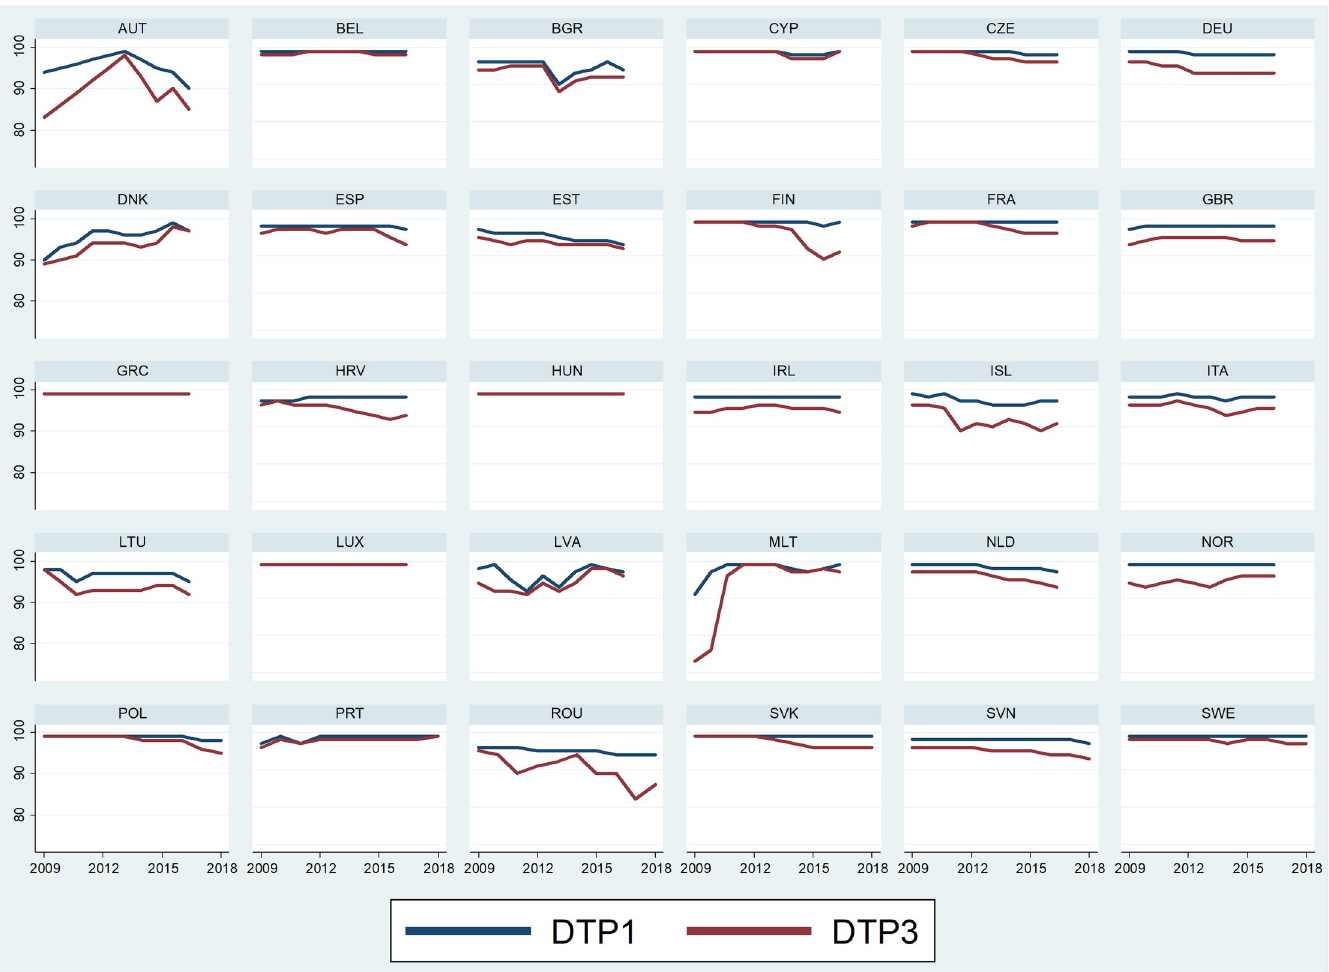
Fig 3. Vaccination coverage (%) for the first and third doses of the DTP vaccine for each country in the period